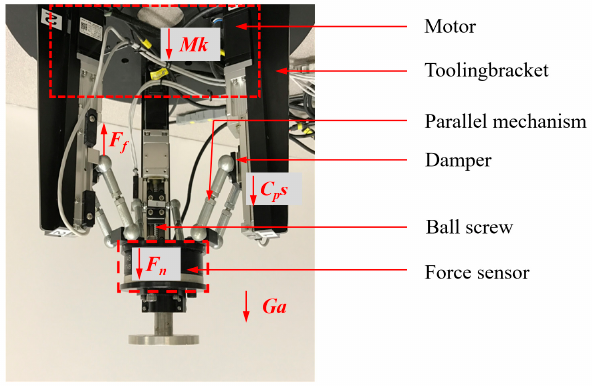
Figure 2. Force analysis of the end-e ff ector.